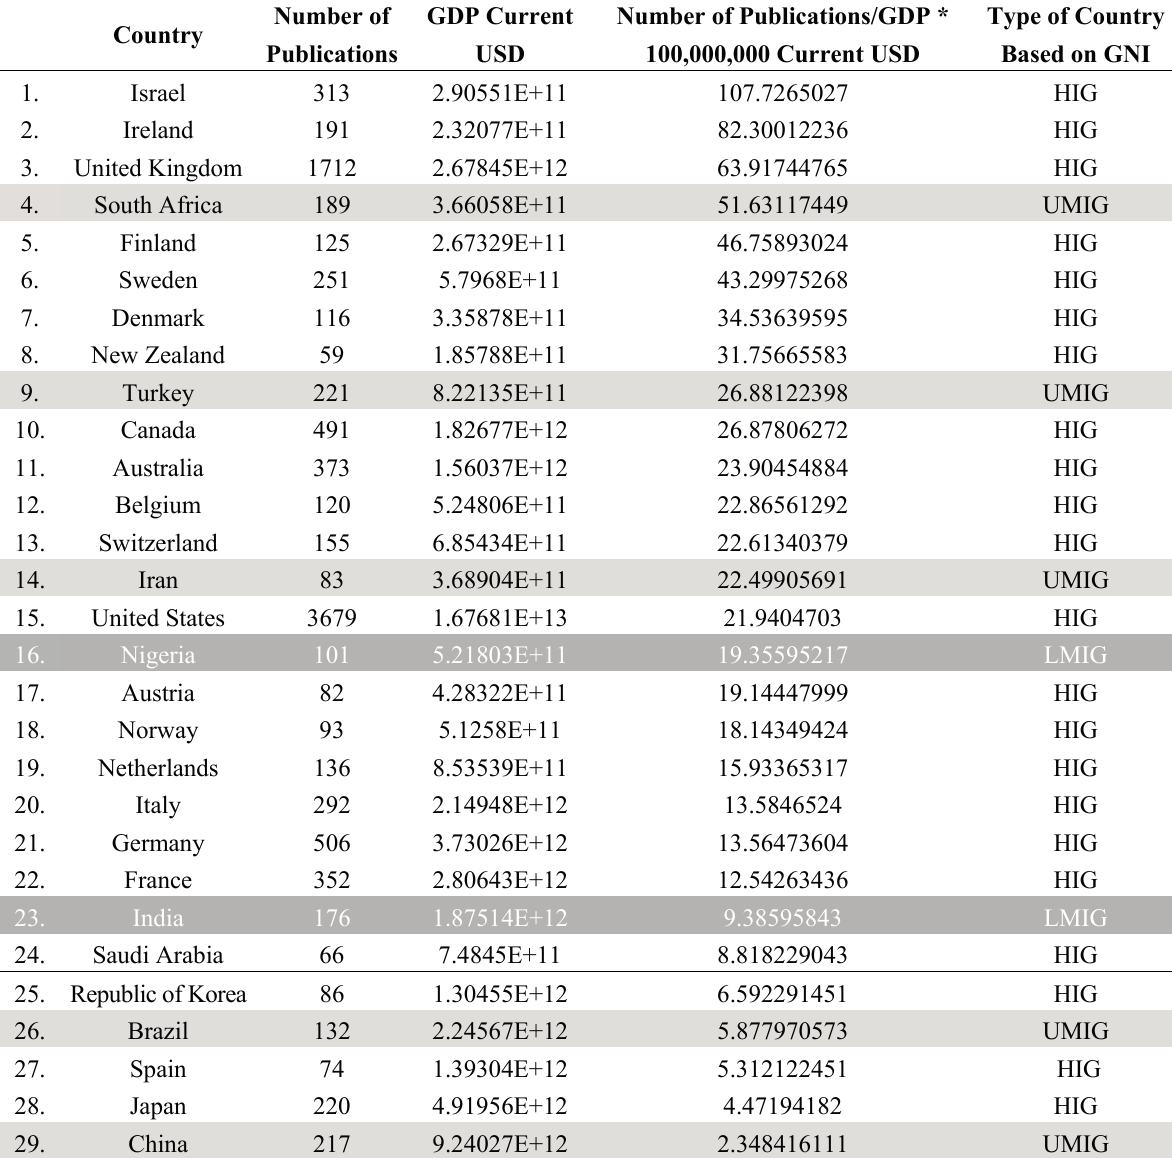
Table 2. Ratio of the number of CS publications and Gross Domestic Product (GDP) in current US-Dollars